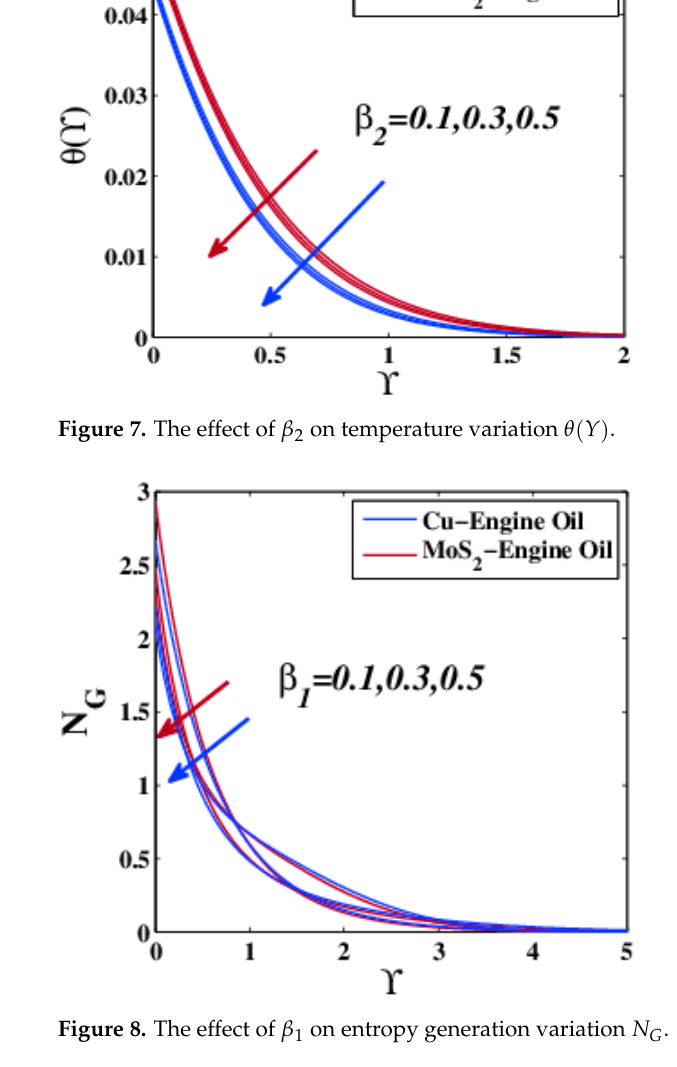
Figure 8. The effect of β 1 on entropy generation variation N G .